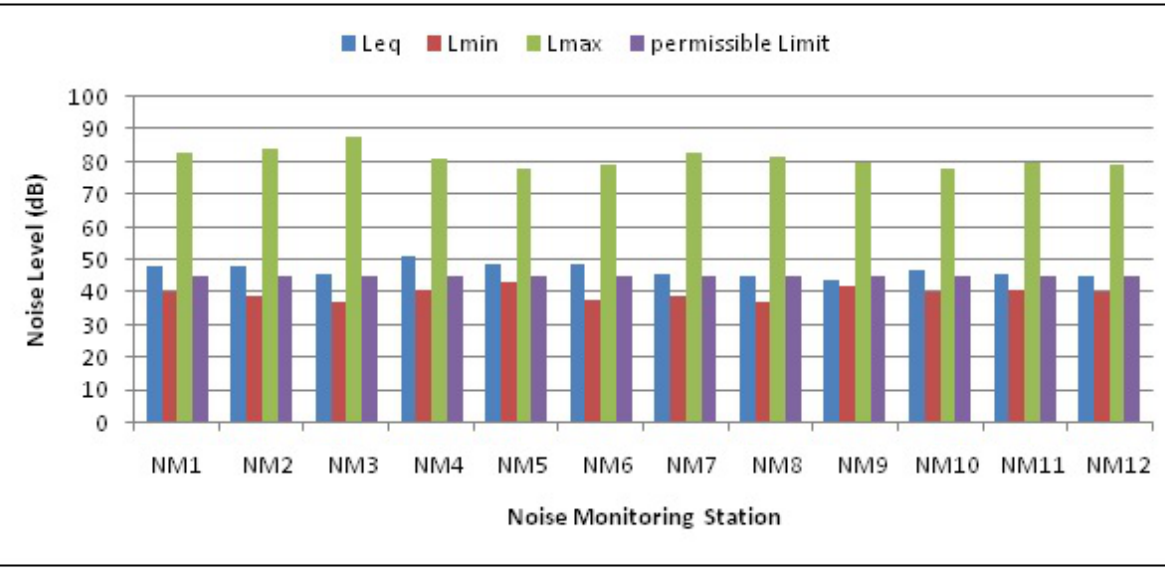
digitize the map and the same has been used for 3D noise